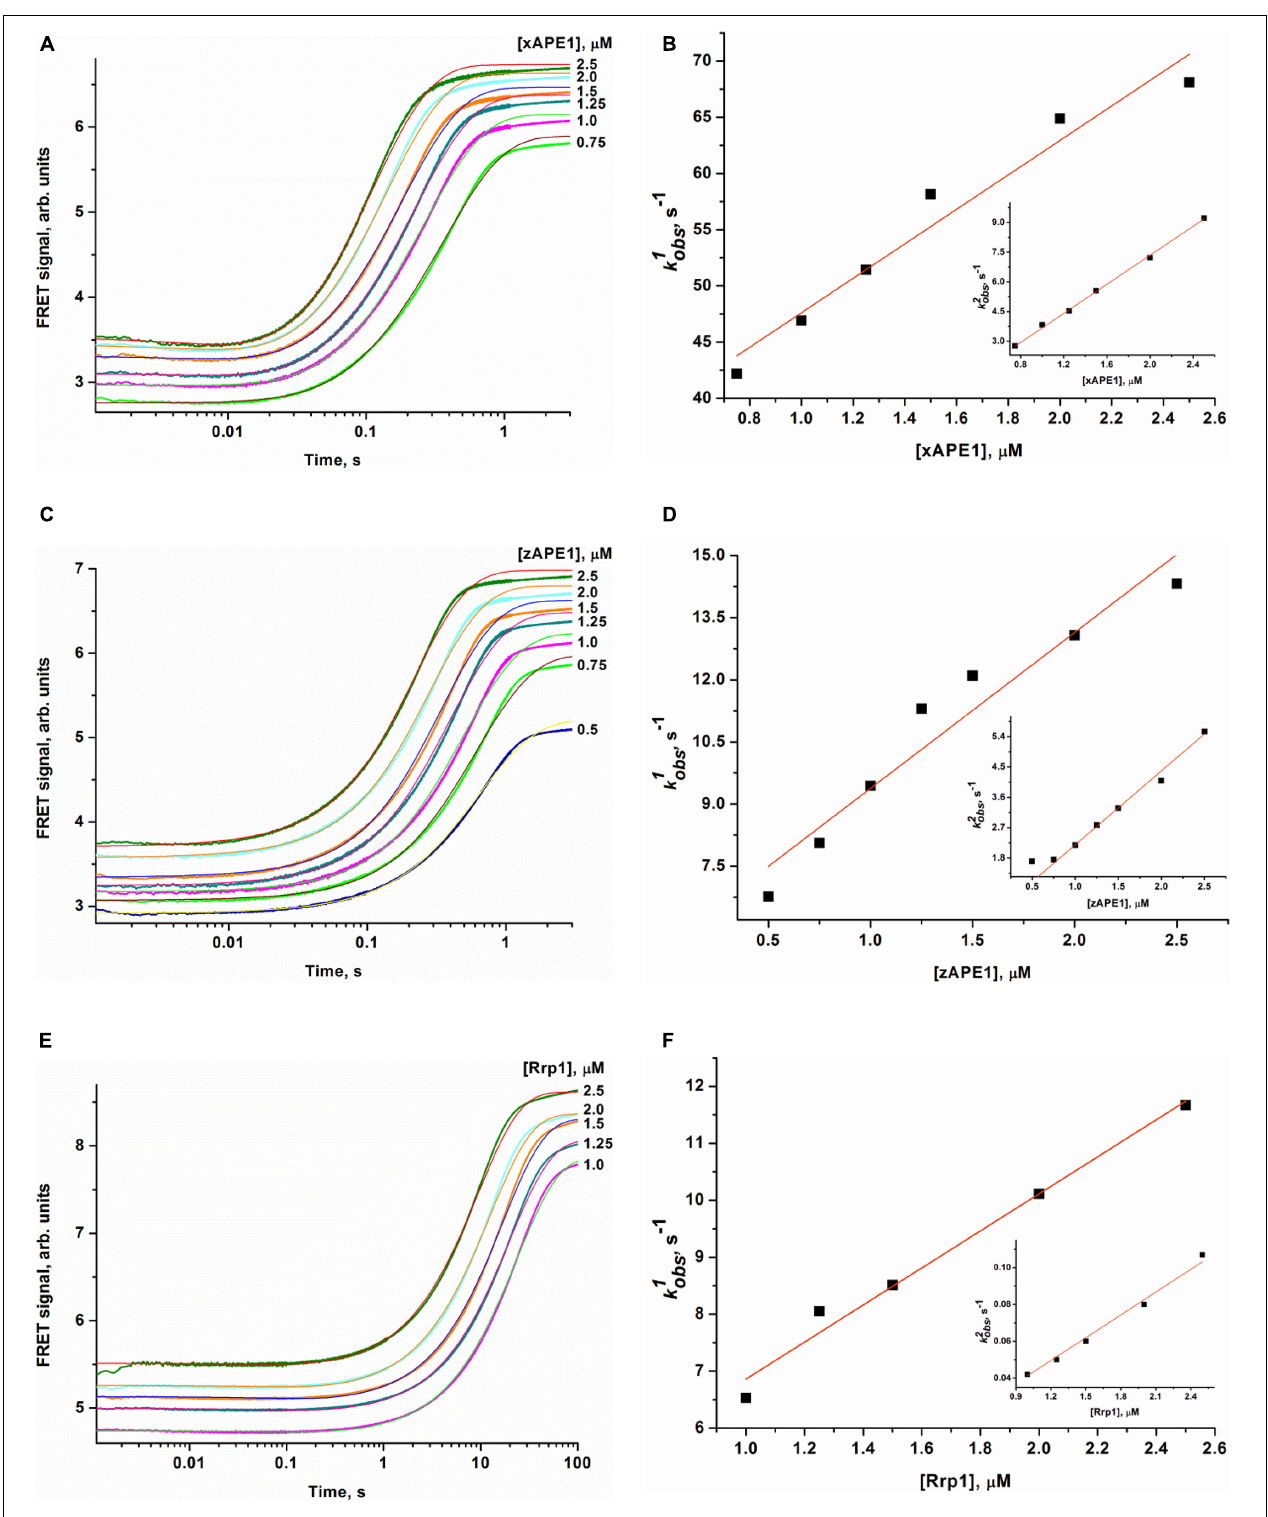
FIGURE 4 | Changes in the FRET signal during the interaction of xAPE1 (A,B) , zAPE1 (C,D) , or Rrp1 (E,F) with the FRET-F-substrate. (FRET-F) = 1.0 µ M, and concentrations of enzymes are shown on the right in the panel. Individual traces were fitted to double-exponential Eq. 1, and the dependences of the observed rate constants k obs1 and k obs2 on enzyme concentration were linearly fitted to Eqs 2 and 3, respectively.